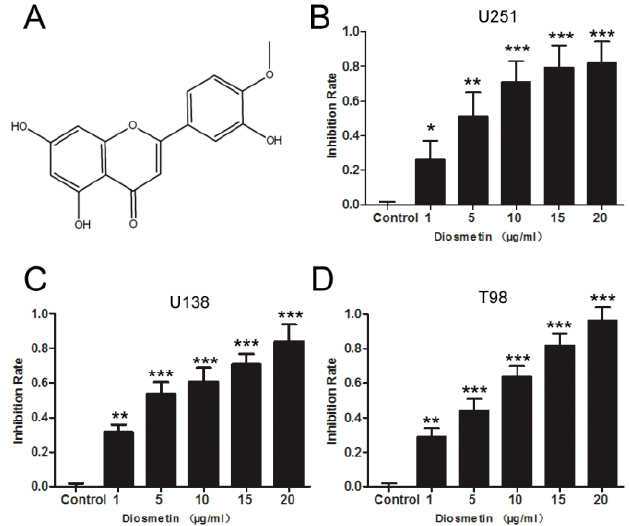
Figure 1. Diosmetin inhibited the proliferation of glioma cells. ( A ) The structure of diosmetin. MTT assay for the case of cell proliferation of ( B ) U251, ( C ) U183, and ( D ) T98; n = 6, and the data are presented as the mean ± standard deviation. Compared with the control group, * p < 0.05, ** p < 0.01, *** p < 0.001.